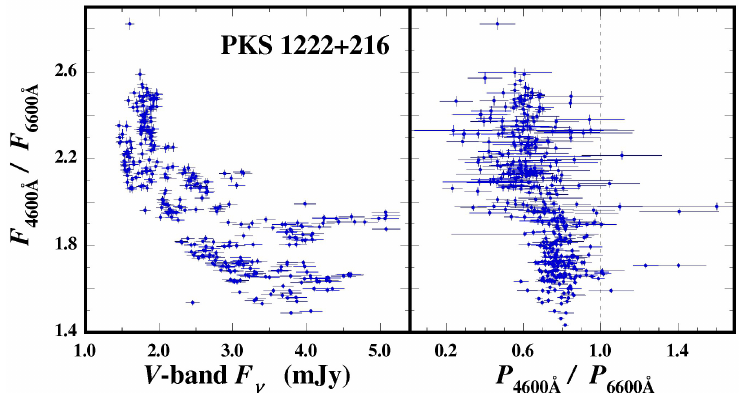
Figure 5. Observed correlations between optical color and brightness ( left panel ) and the strength of wavelength dependence seen in P ( right panel ) as measured by the ratio in polarization observed at 4600 Å and 6600 Å for PKS 1222+216.